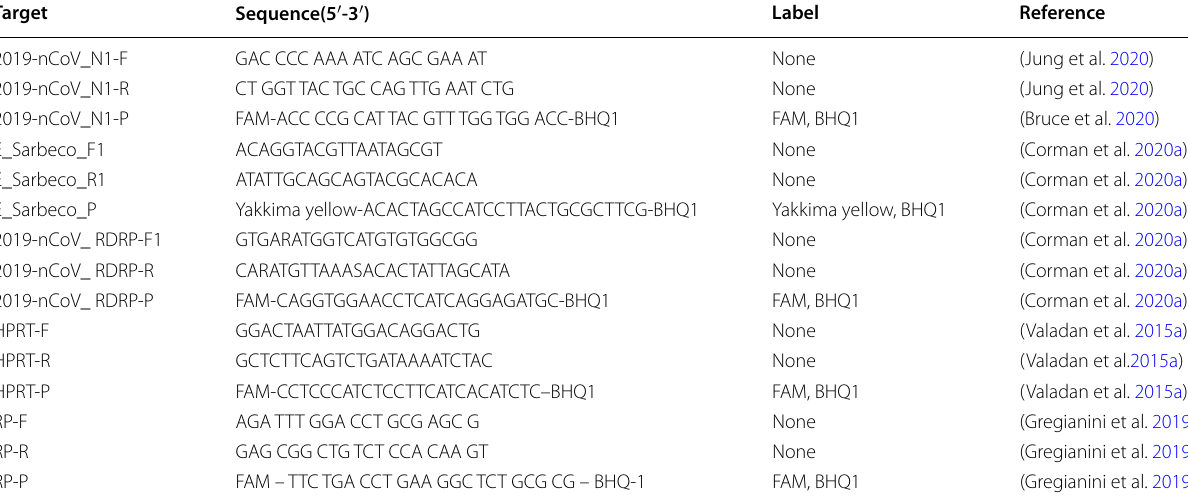
Table 1 The sequences and concentrations of primer and probe sets used in the PCR reactions Target Sequence(5 ′ ‑3 ′